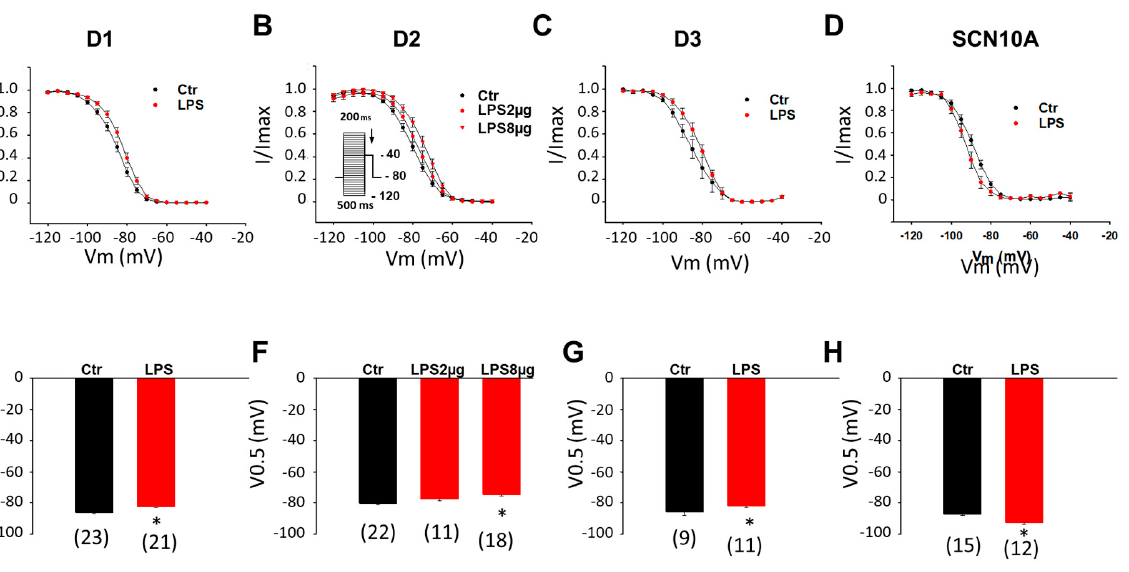
Figure 3. LPS effects on inactivation of sodium channels in hiPSC-CMs from healthy donors and the BrS-patient. Cells were treated with vehicle (Ctr) of LPS of 2 μ g/mL or 8 μ g/mL (in D2 cells) for 48 h. ( A ) Inactivation curves of peak sodium channel currents (I Na ) recorded in hiPSC-CMs from D1 healthy donor. ( B ) Inactivation curves of peak I Na recorded in hiPSC-CMs from D2 healthy donor. ( C ) Inactivation curves of peak I Na recorded in hiPSC-CMs from D3 healthy donor. ( D ) Inactivation curves of peak sodium channel currents (I Na ) recorded in SCN10A-hiPSC-CMs. ( E ) Mean values of potential at 50% inactivation (V0.5) in hiPSC-CMs from D1 healthy donor. ( F ) Mean values of potential at 50% inactivation (V0.5) in hiPSC-CMs from D2 healthy donor. ( G ) Mean values of potential at 50% inactivation (V0.5) in hiPSC-CMs from D3 healthy donor. ( H ) Mean values of potential at 50% inactivation (V0.5) in SCN10A-hiPSC-CMs. Numbers given in ( E – H ) represent the number of cells of measurements also for ( A – D ). * p < 0.05 versus Ctr according to t -test or one-way ANOVA with Holm-Sidak post-test ( F ).